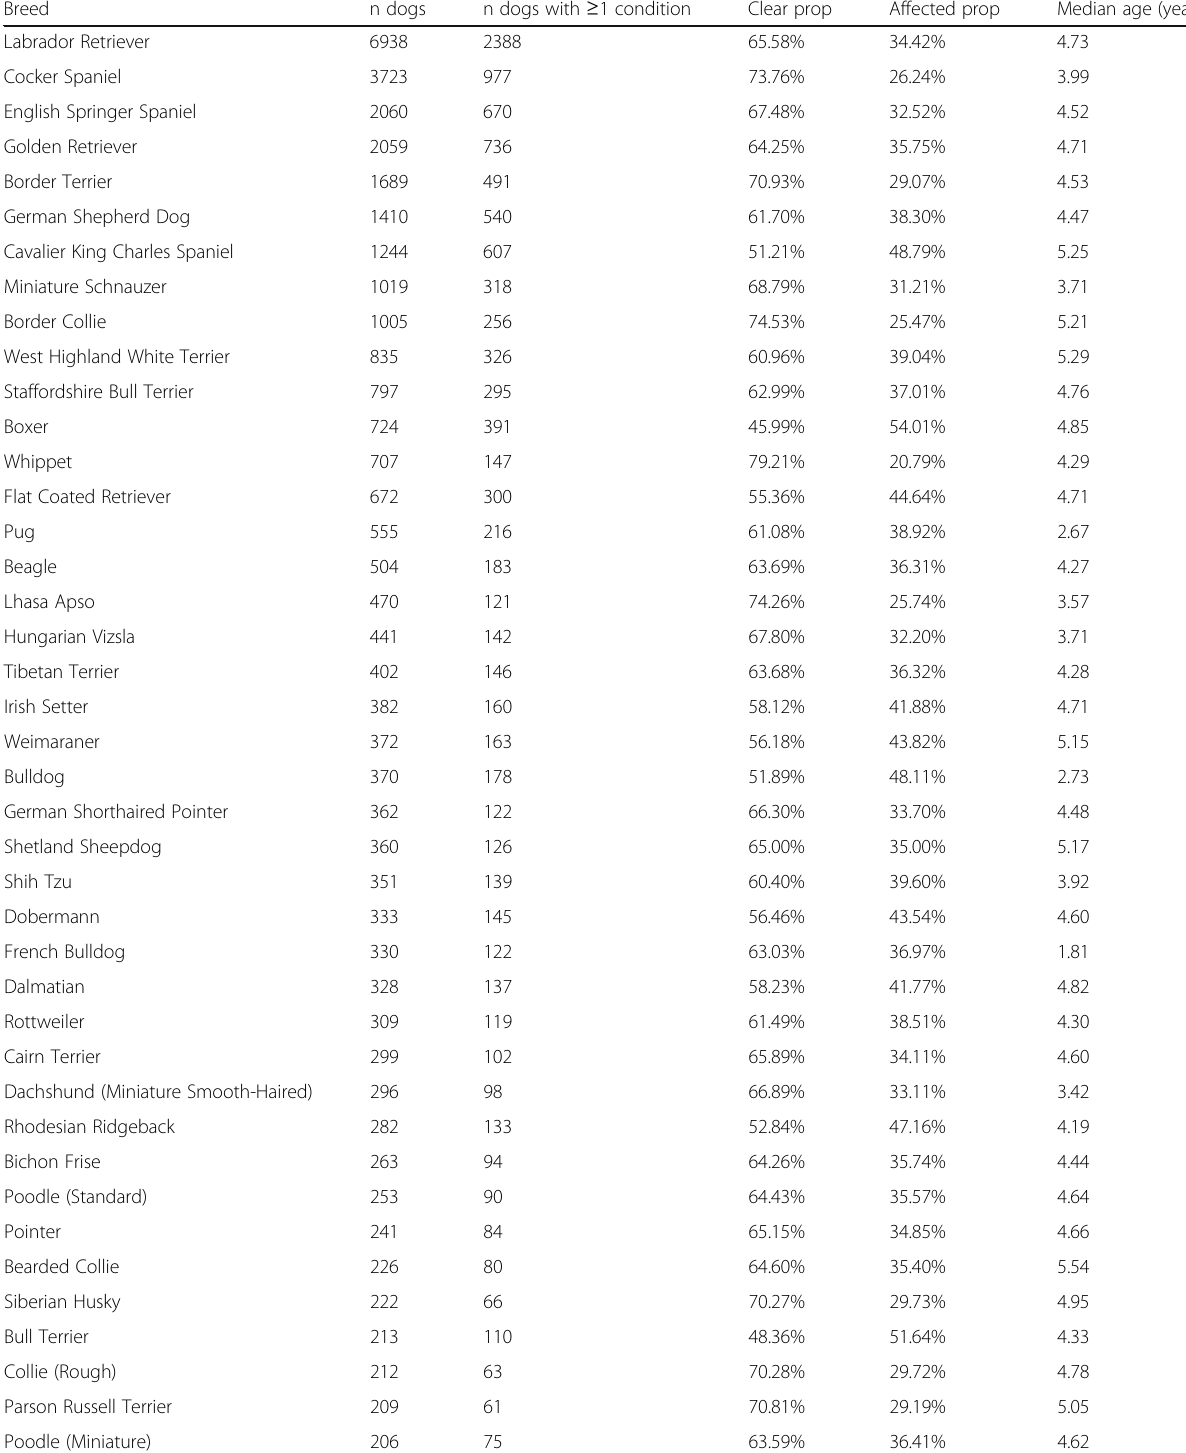
Table 4 The number of unique live dogs surveyed, number of dogs with one or more reported incident of disease/condition, and clear (no reported disease/condition), affected ( ≥ 1 reported disease/condition) proportion and median age (years), for breeds with reports on ≥ 200 unique live dogs ( n = 41